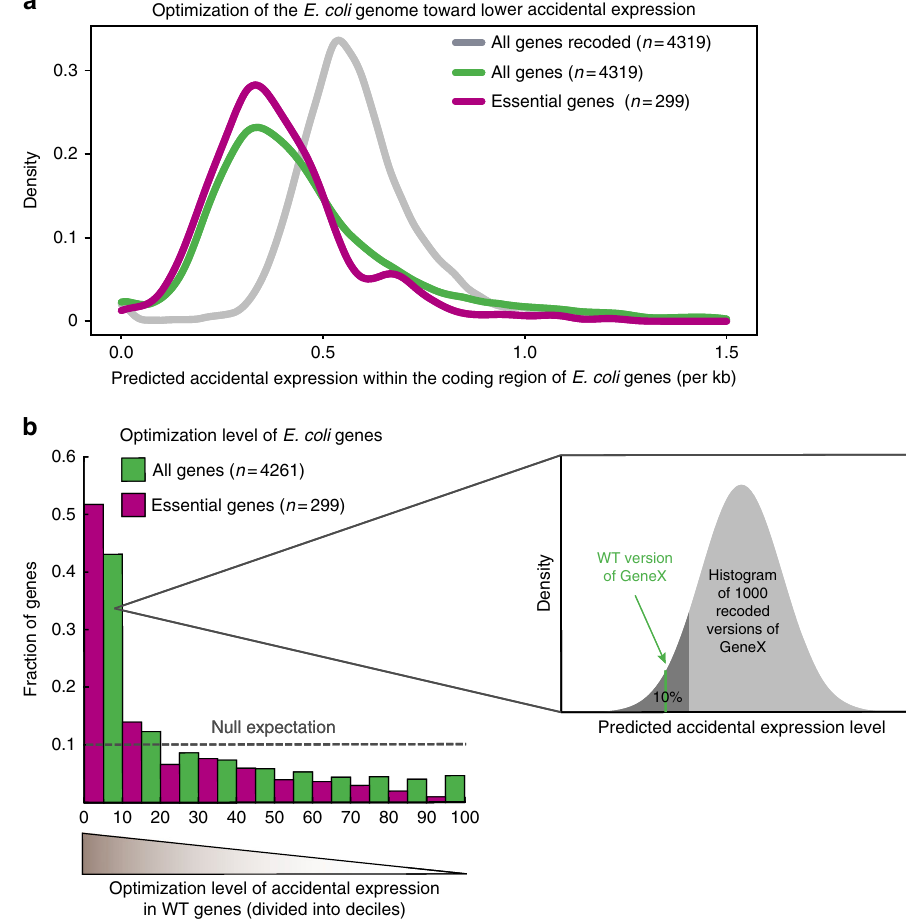
Fig. 5 Selection against the occurrence of random promoters in the coding region of genes. We evaluated promoters that accidentally occur across the genome by searching for promoter motifs in the coding region of E. coli . As a reference we did the same evaluation for 1000 alternative versions of the E. coli coding region by recoding each gene with synonymous codons while preserving the amino-acid sequence and the codon bias. a Density plots of accidental expression in the coding sequences of E. coli genes. Distribution of a thousand recoded versions of E. coli coding region are shown in gray (the value that represent each gene is the median of its 1000 shuf fl ed versions), the accidental expression of the WT E. coli genes is shown in green, and for the subset of essential genes in magenta. The WT version of the genome shows lower rates of predicted accidental promoters, indicating genome-wide minimization of accidental expression. This minimization is further emphasized for the essential genes. b For each WT gene and its 1000 recoded versions a score for accidental expression was calculated. The WT gene was then ranked in the distribution of its 1000 recoded versions (see inset illustration). Ranking values are divided into deciles, for all WT genes (green), and for the subset of essential genes (magenta) demonstrating that ~40% of WT genes and more than 50% of essential genes are ranked at the most optimized decile. Dashed line shows expected histogram if WT genes had similar values to their